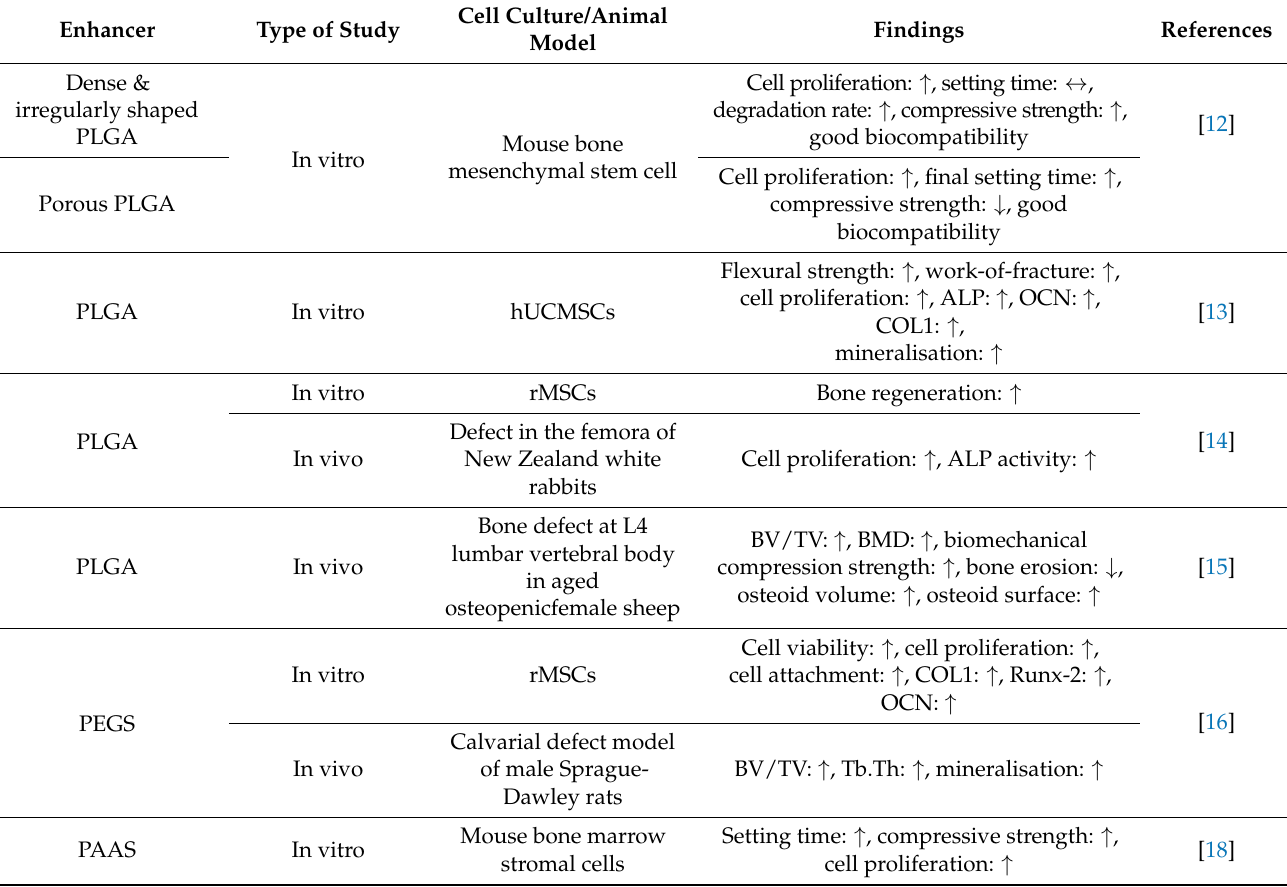
Table 1. Bone-sparing properties of CPC enhanced by